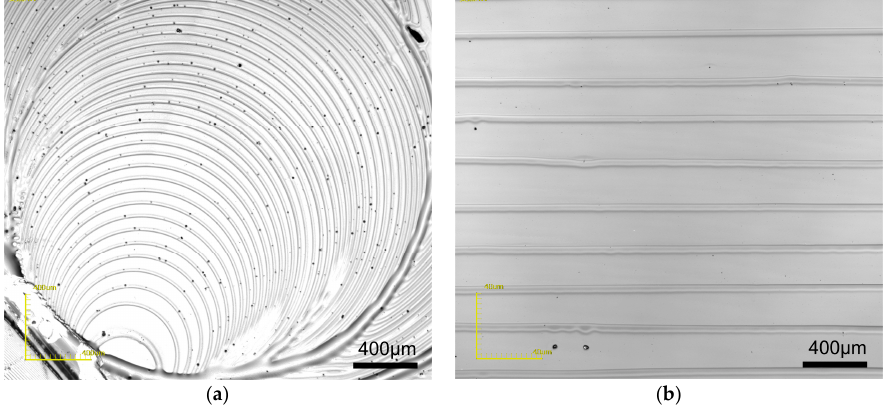
Figure 2. Patterns of PMMA obtained by evaporating ( a ) a single droplet in the center of the clearance and ( b ) wedge meniscus of PMMA solution on silicon wafer at 110 °C hotplate.